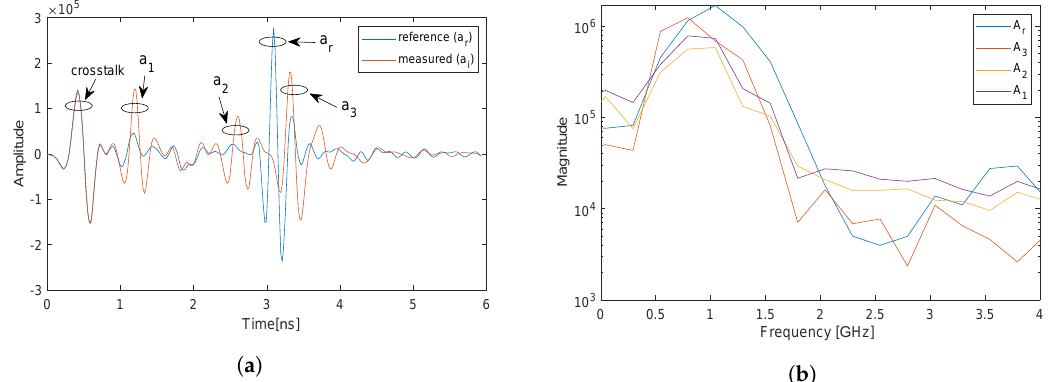
Figure 7. ( a ) Measured time domain signals. ( b ) Magnitude of frequency domain